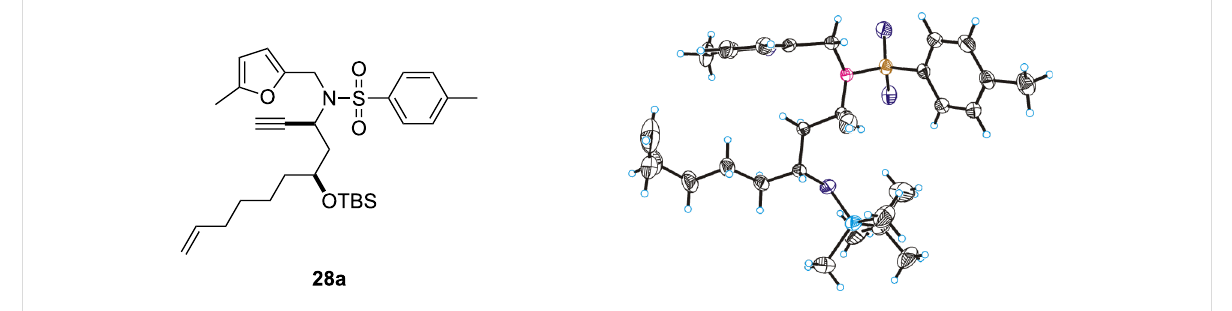
Figure 2: Solid-state molecular structure of 28a